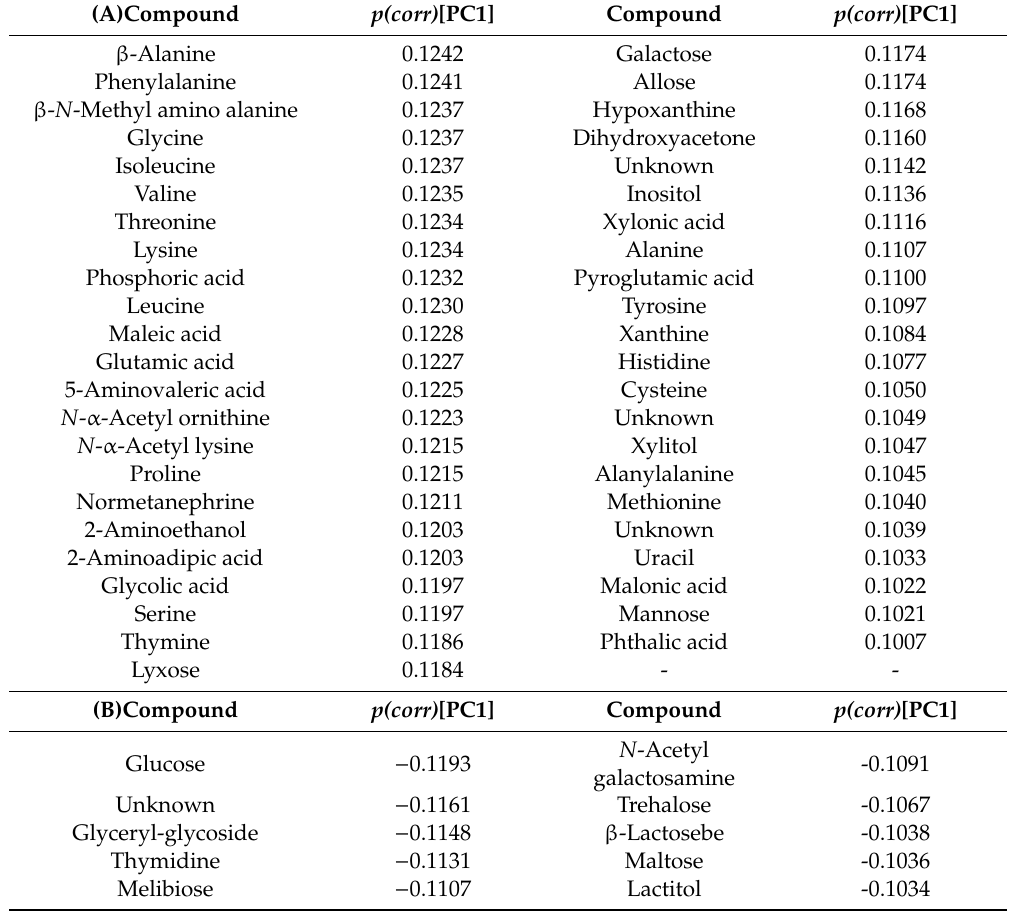
( A ) Compounds plotted on the positive side (bean-based side) along PC1 and factor loadings are shown. ( B )Compoundsplottedonthenegativeside(grain-basedside)alongPC1andfactorloadingsareshown. Compounds with factor loadings of greater than ± 0.1 were selected as